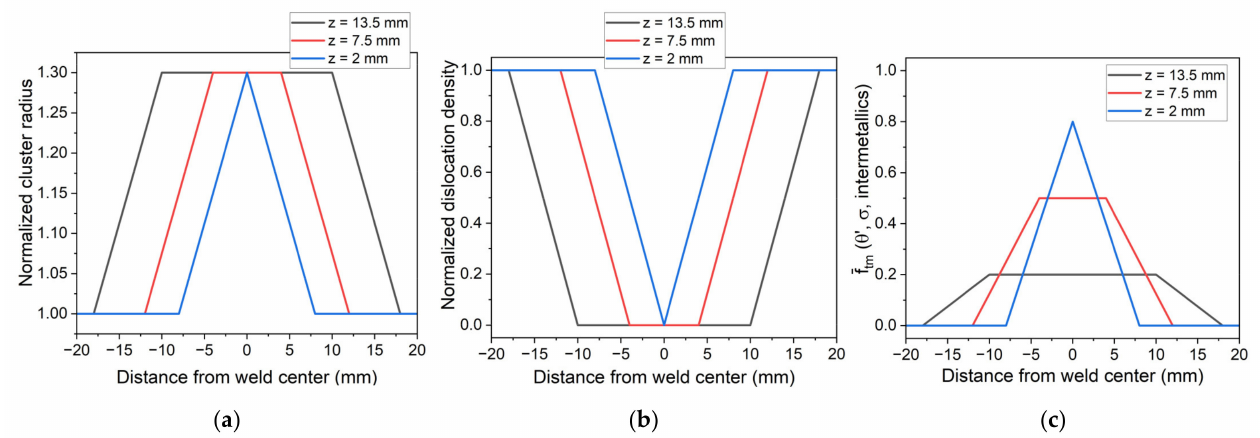
Figure 13. Initial states imposed according to SAXS measurements [6] at different locations in the weld for the ( a ) normalized radius of clusters; ( b ) normalized dislocation density; and ( c ) maximum normalized volume fraction of non-hardening